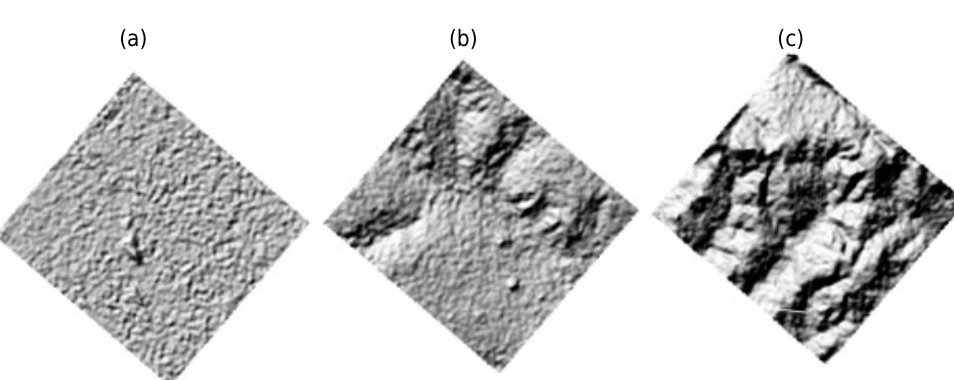
Figure 2. Texture aspects on shaded SRRM images ( shade-relief ), indicating the degree of dissection of the municipality of São Miguel do Araguaia, state of Goiás, Brazil. (a) Very weak dissection (mfr); (b) Weak dissection (fr); and (c) Medium dissection